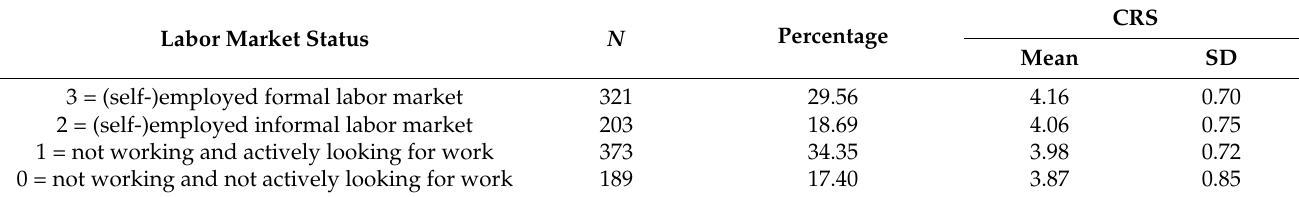
Table 5. Frequencies of labor market outcomes and mean religiosity by labor market outcome.